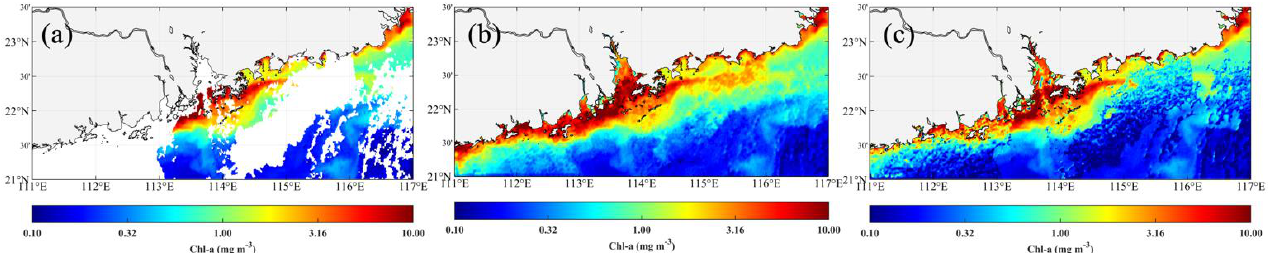
Figure 10. Comparison of Attention U-Net and U-Net reconstruction in study domain; the C chla image was obtained on 9 July 2003. ( a ) Satellite-derived C chla ; ( b ) Attention U-Net-reconstructed C chla ; ( c ) U-Net-reconstructed C chla .